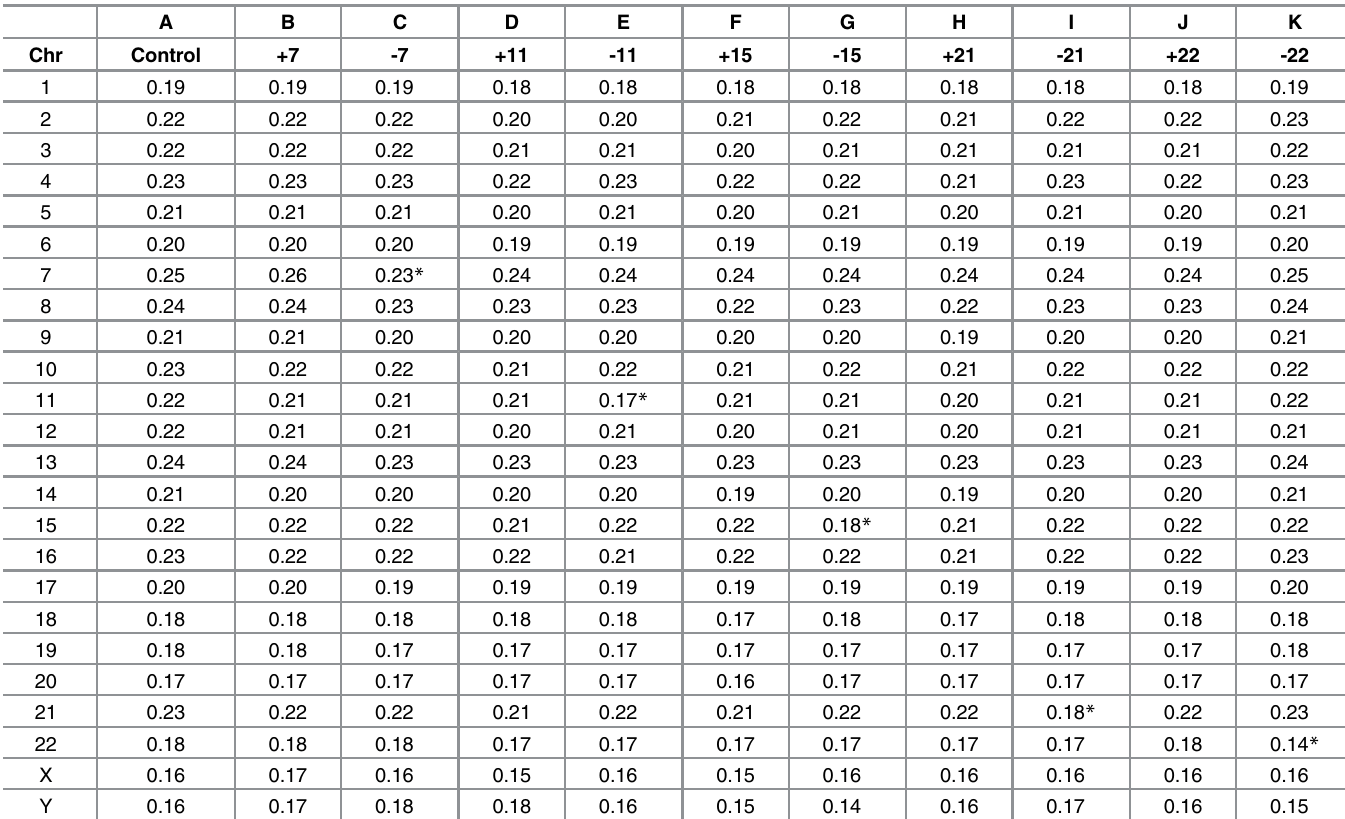
Table 4. Methylation profiles of individual chromosomes for blastocysts with a specific chromosome constitution: A) Diploid Control, B) Trisomy 7, C) Monosomy 7, D) Trisomy 11, E) Monosomy 11, F) Trisomy 15, G) Monosomy 15, H) Trisomy 21, I) Monosomy 21, (J) Trisomy 22, and (K) Mono- somy 22 ( * P <